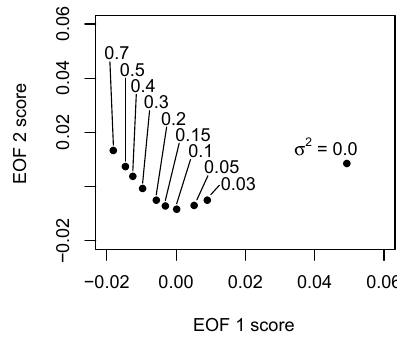
Figure 7. The relationship between the particle roughness parame- ter and the EOF1 score. The natural logarithm of the particle rough- ness parameter is nearly linear to the EOF 1 score. This implies that the particle roughness can be directly inferred from the EOF 1